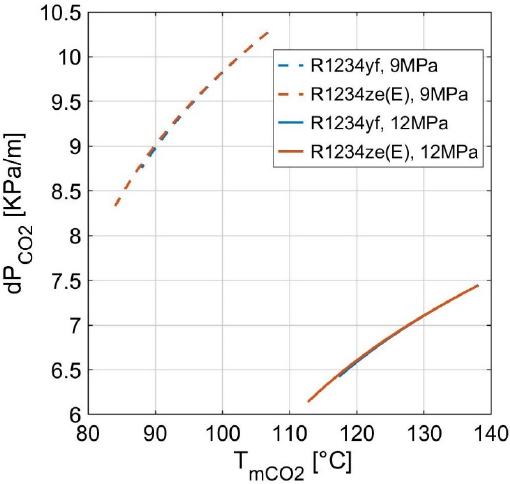
Figure 10. Total hot stream pressure drop at various mean hot stream temperatures.